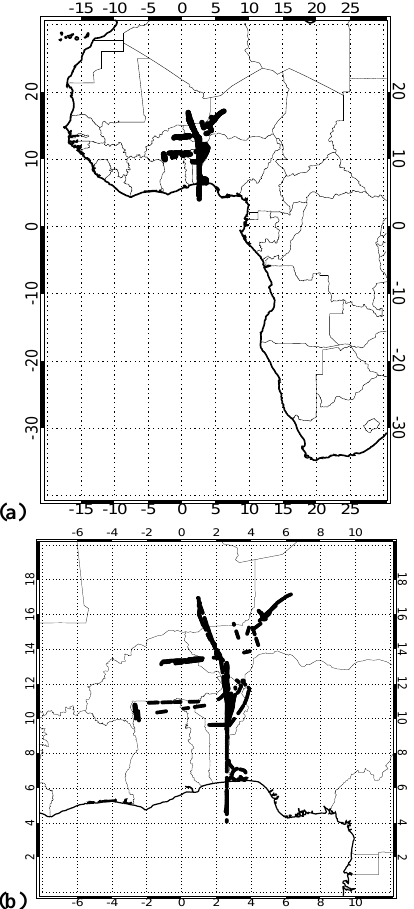
Fig. 1. Locations of the BAe146 aircraft during the AMMA cam- paign when OH or HO 2 data are available, showing (a) the wider geographical area and (b) a close up of the region of